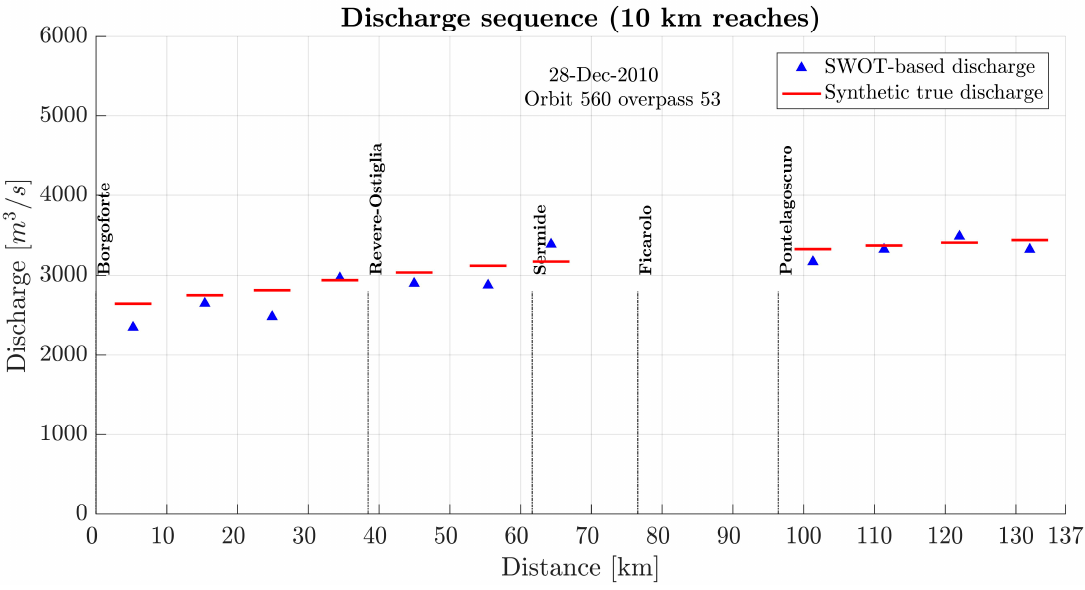
Figure 6. Example of the spatial discharge monitoring expected from SWOT: synthetic true (red segments) and SWOT-based (blue triangle) discharges from orbit 560 (overpasses no. 53) considering Δ x equal to 10 km.